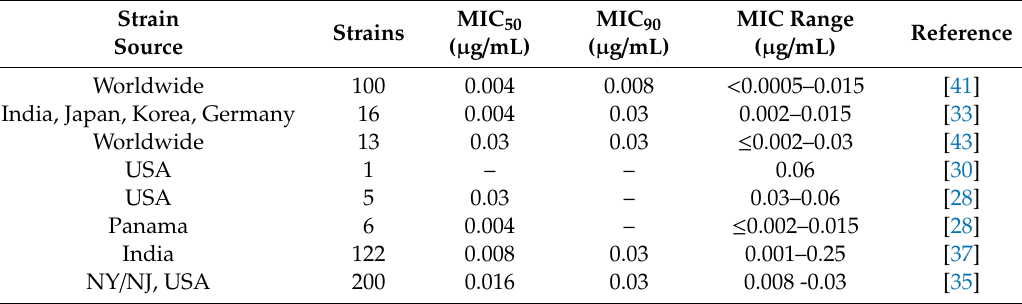
Table 2. CLSI MGX MIC values vs. collections of C. auris strains.